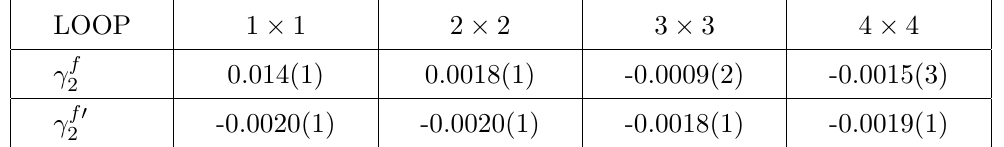
Table 5. Values of the parameters (cid:13) f